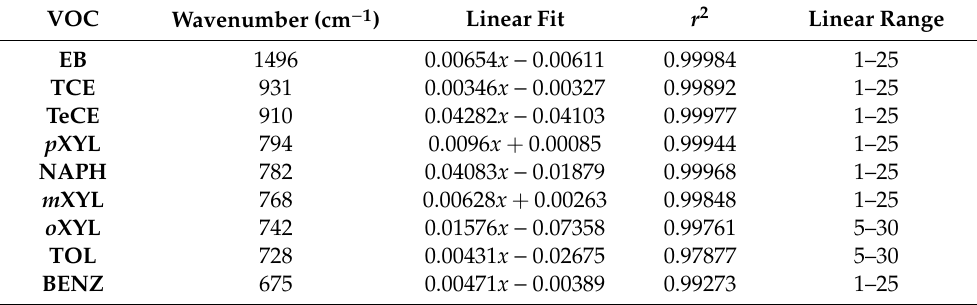
Table 3. Overview of the calibration functions established from evaluating the peak area at equilibrium conditions with the evaluated wavenumber, linear fit function, and r 2 -value of the respective